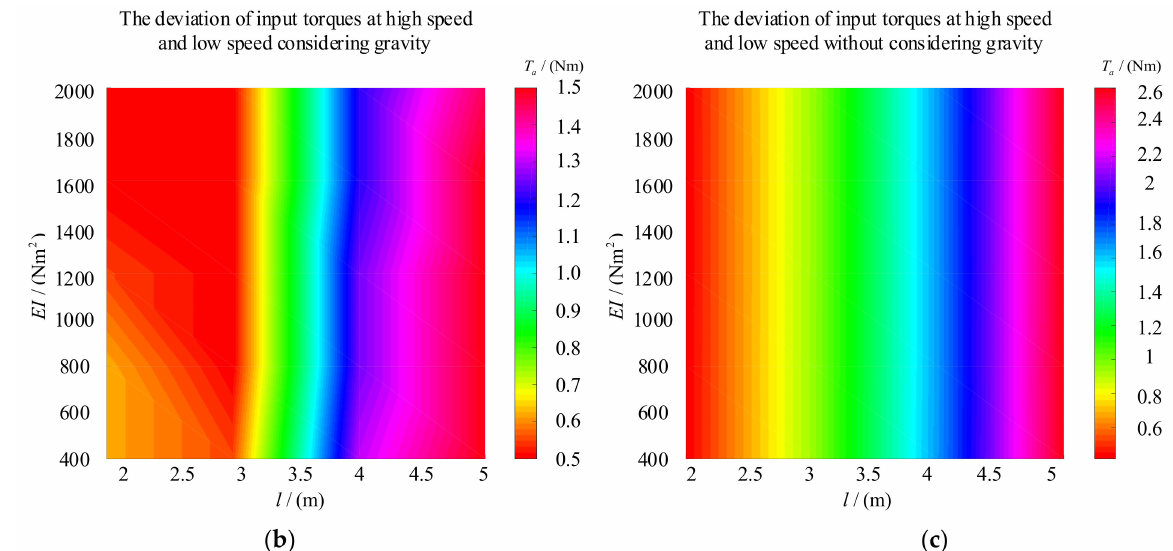
Figure 2. Input torque of flexible manipulator. ( a ) The effect of gravity on the input torque. ( b ) The input torque deviation considering gravity. ( c ) The input torque deviation without considering gravity. In high speed, the maximum speed in Equation (31) is set at 6 rad/s. While in the case of low speed, the maximum speed in Equation (31) is set at 3 rad/s. The mass of the flexible manipulator is 1